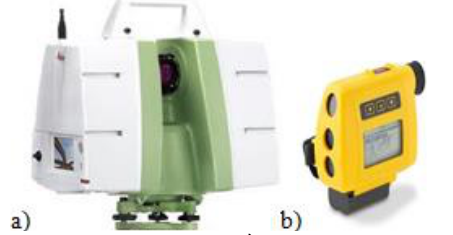
Figure 1: Surveying devices: a) Leica scanstation C10 b) Trimble LaserAce 1000